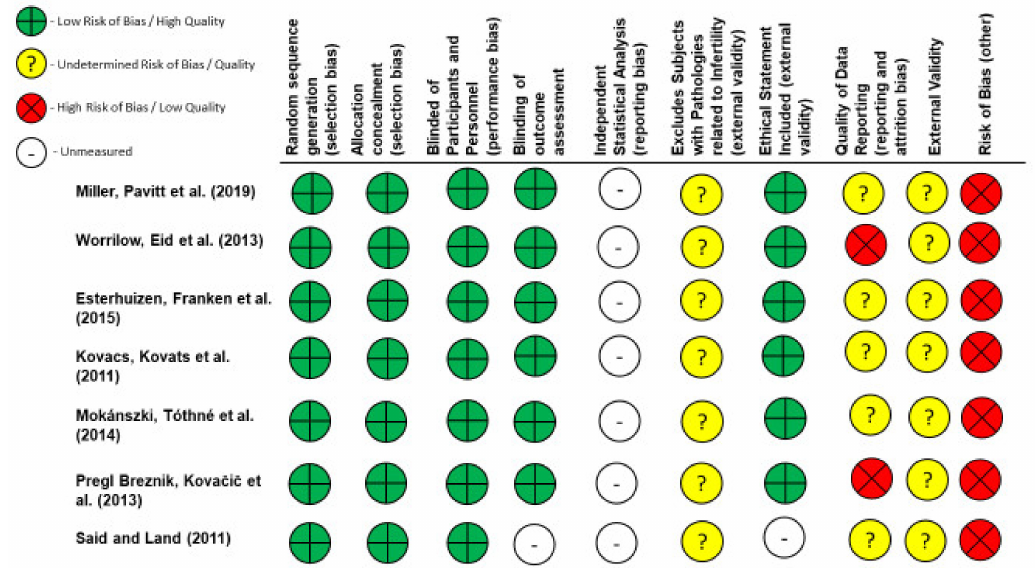
Figure 3. A summary of the authors’ judgement on quality and bias assessment results of the 7 reviewed studies for study question 1—Is sperm HAB score prior to insemination predictive of clinical outcomes? Green: low risk of bias/high quality, Yellow: undetermined risk of bias/quality, Red: high risk of bias/low quality, White: assessment does not apply. Studies were considered at low risk of biases related to selection and performance given that no intervention was involved in the study groups, and procedures were of a diagnostic nature without interfering with patient